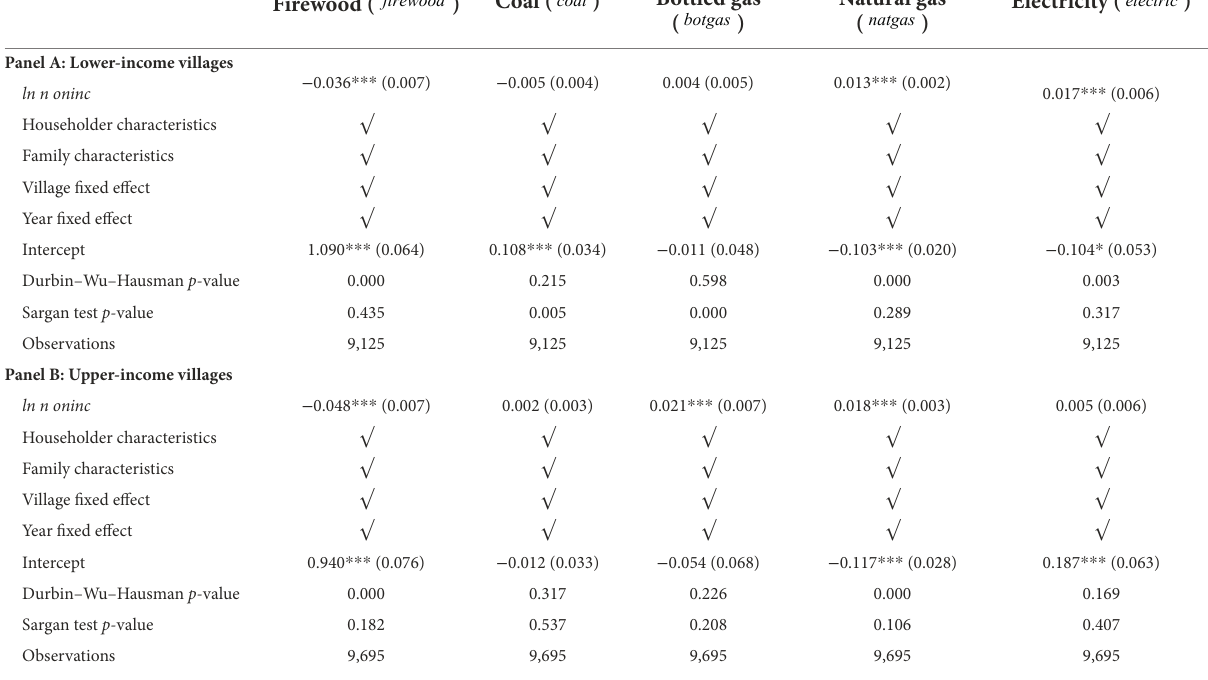
TABLE 9 Heterogeneity test: Estimated by income